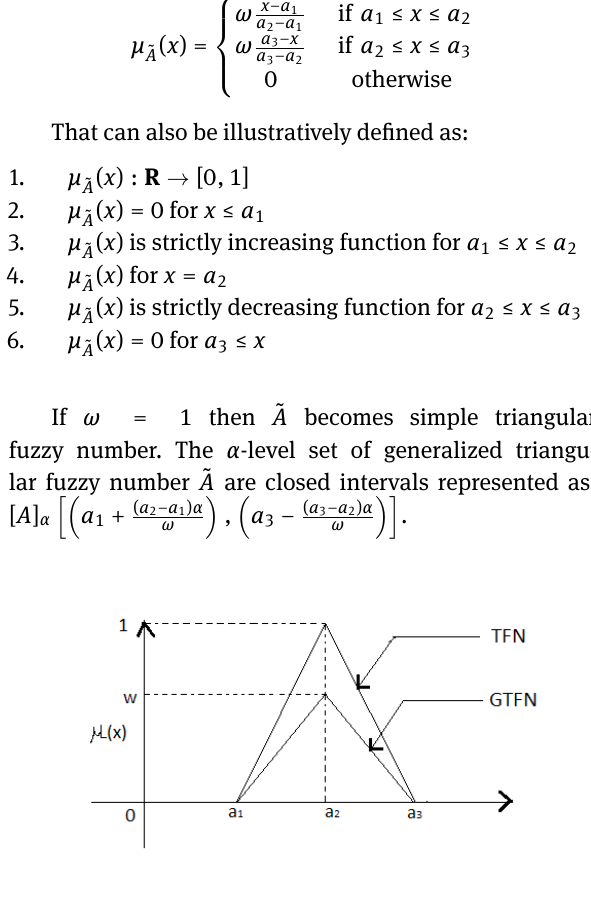
Fig. 1: Triangular and generalized triangular fuzzy